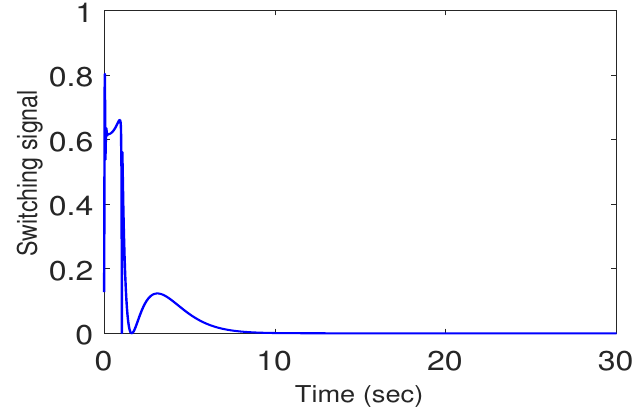
Figure 5. Switching signal in Case 1.